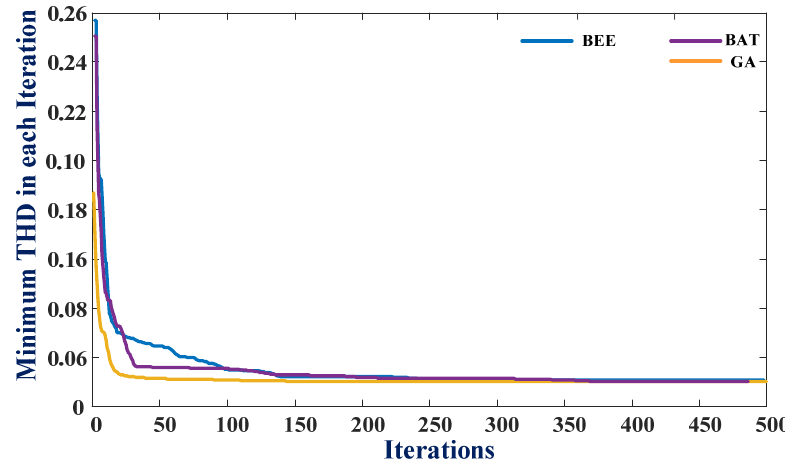
Figure 6. Variation of minimum THD with iterations count.